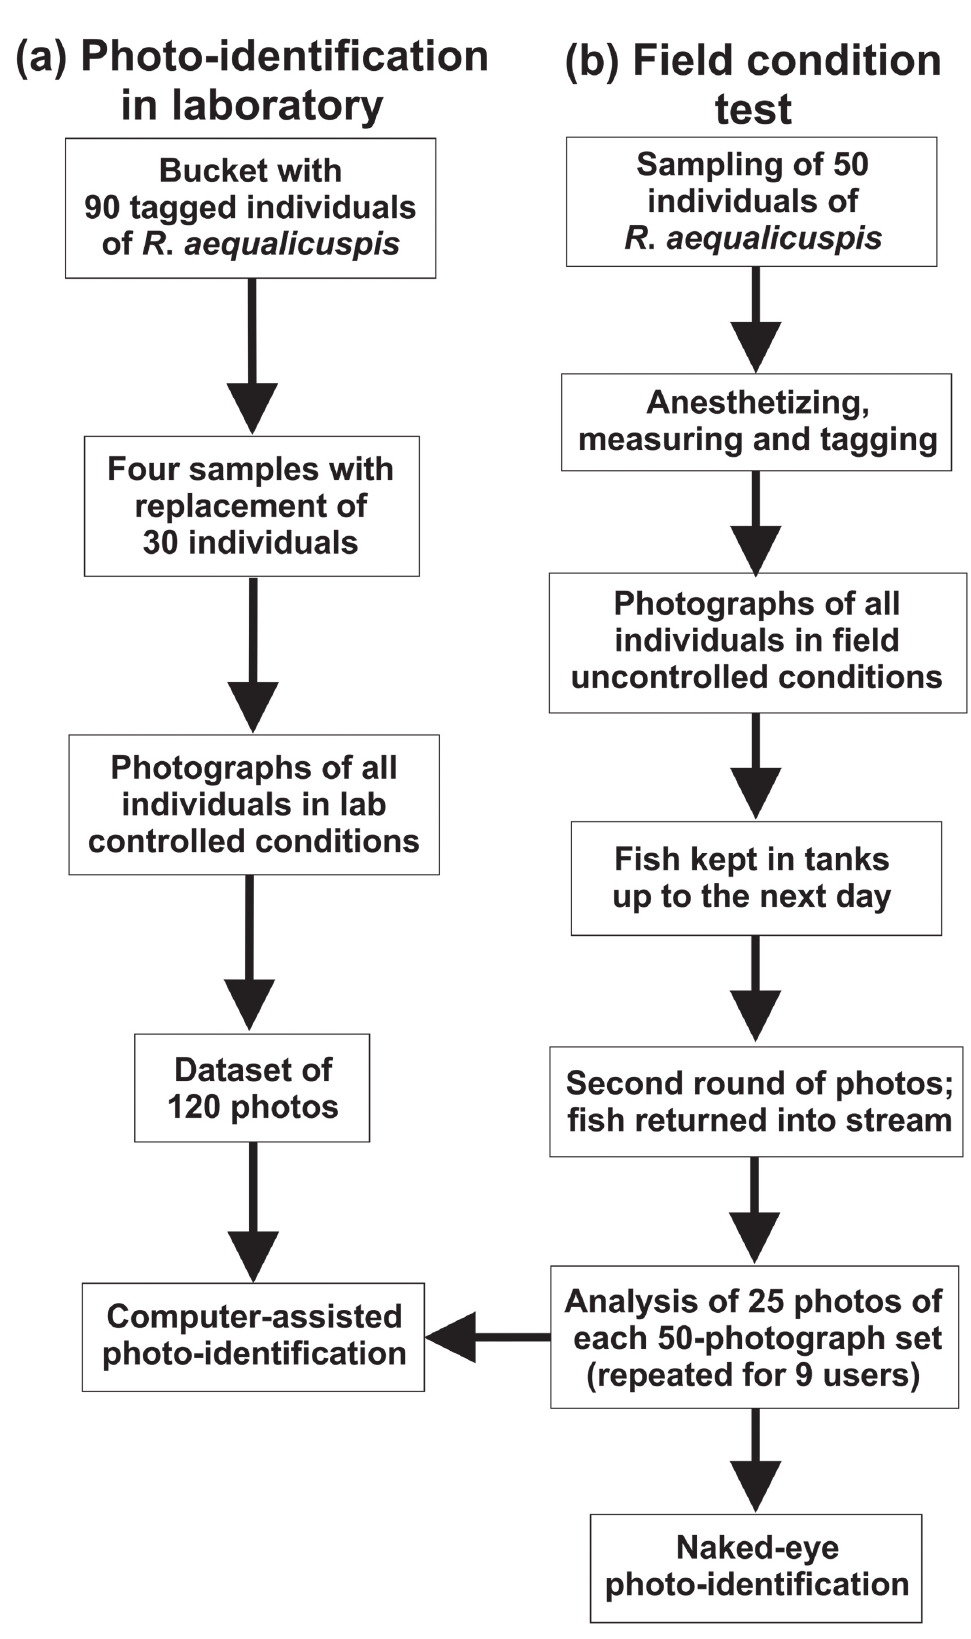
Fig. 2. Diagram showing the steps employed to assess the performance of photo-identification technique in laboratory (a) and field (b) conditions for Rineloricaria aequalicuspis